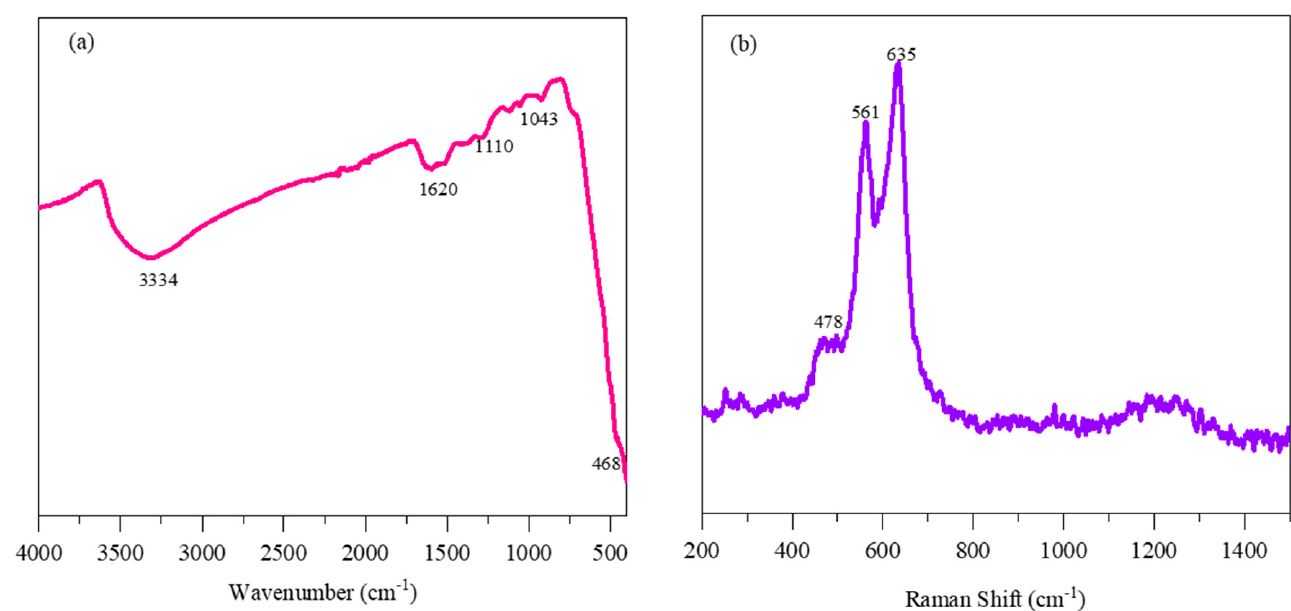
deconvoluted peaks at ~529.2 eV and ~531.1 eV, which mainly belong to the tetravalent